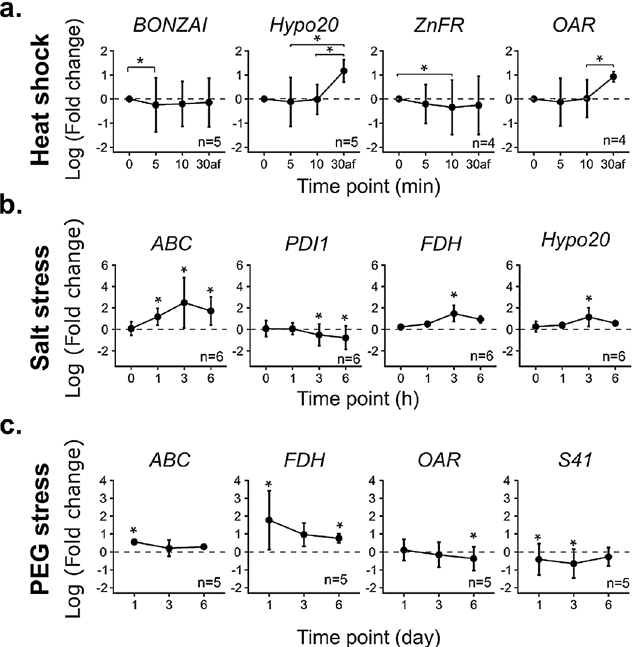
Figure 6. Log transform expression pattern of four marker genes in each abiotic stress normalized to the most adapted pair of reference genes. ( a ) BONZAI, Hypo20, ZnFR and OAR mRNA amounts relative to control at 0 min were measured in response to heat shock. 30af: 30 min at 20 °C after heat shock. Statistically significant differences between each time point were determined using Kruskal–Wallis followed by Dunn test (* P < 0.05). ( b ) ABC, PDI1, FDH and Hypo20 transcripts accumulation relative to control were calculated in response to salt stress. Statistically significant differences between treated sample and control were determined using Kruskal– Wallis followed by Dunn test (* P < 0.05). ( c ) ABC, FDH, OAR, and S41 mRNA amounts relative to control were quantified in response to 30% (w/v) PEG induced dehydration stress. Statistically significant differences between treated sample and control were determined using Kruskal–Wallis followed by Dunn test (* P <